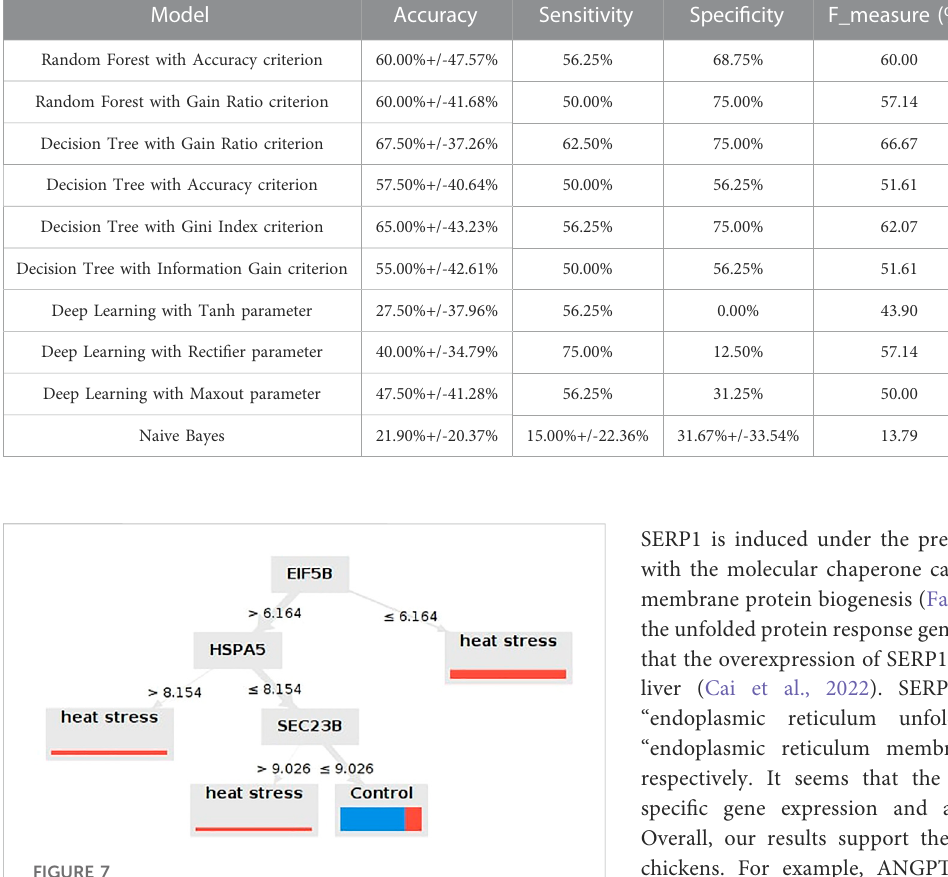
FIGURE 7 Decision Tree that identi fi ed the most important biomarkers for thedifferentiationofchickensundercuteheatstressfromthoseunder normalrearingcondition.OnlytheDecisionTreeofthemostaccurate criterion (i.e., Gain Ratio) was shown